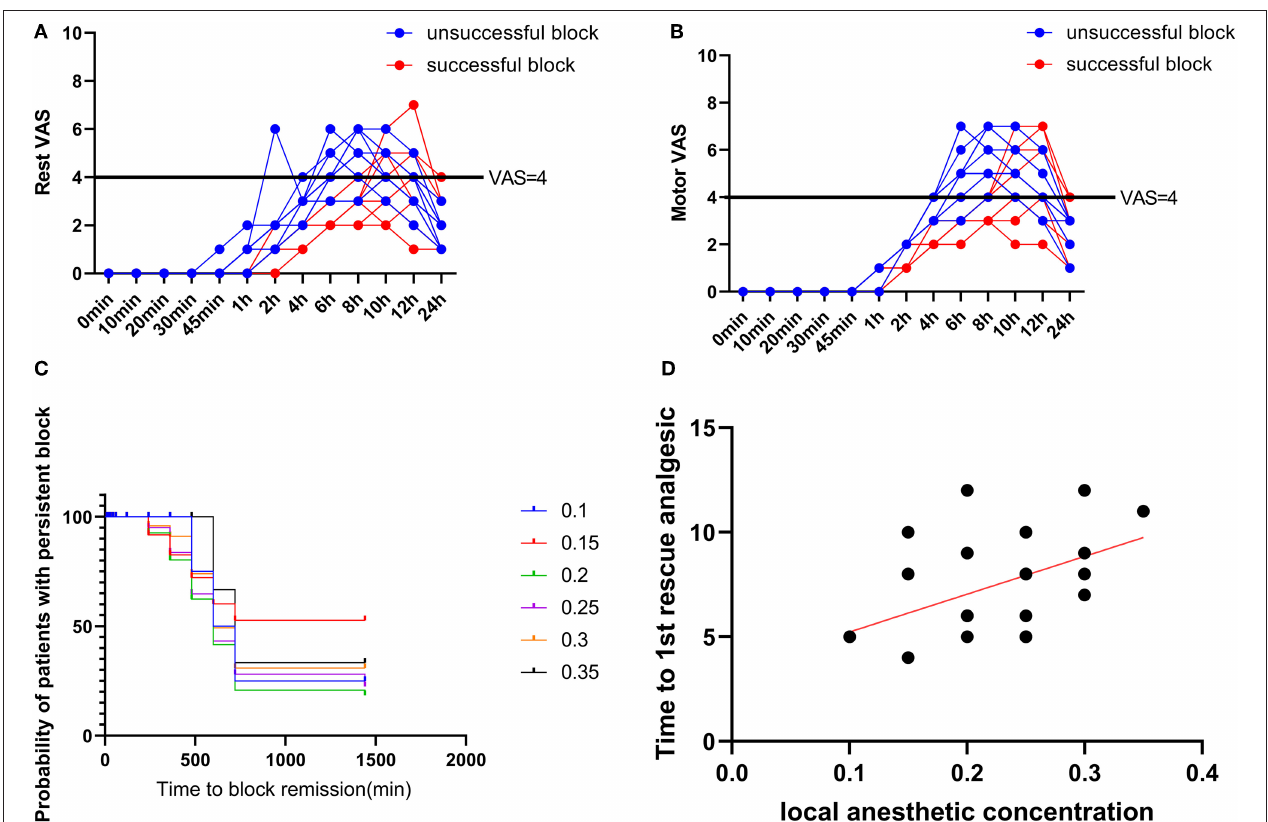
FIGURE 3 | Postoperative pain scores. (A) Rest pain score 24h after surgery. (B) Motor pain score 24h after surgery. (C) Duration of the Interscalene Brachial Plexus Block with different concentrations of ropivacaine. (D) Correlation between ropivacaine concentration and time to first rescue analgesic in interscalene brachial plexus